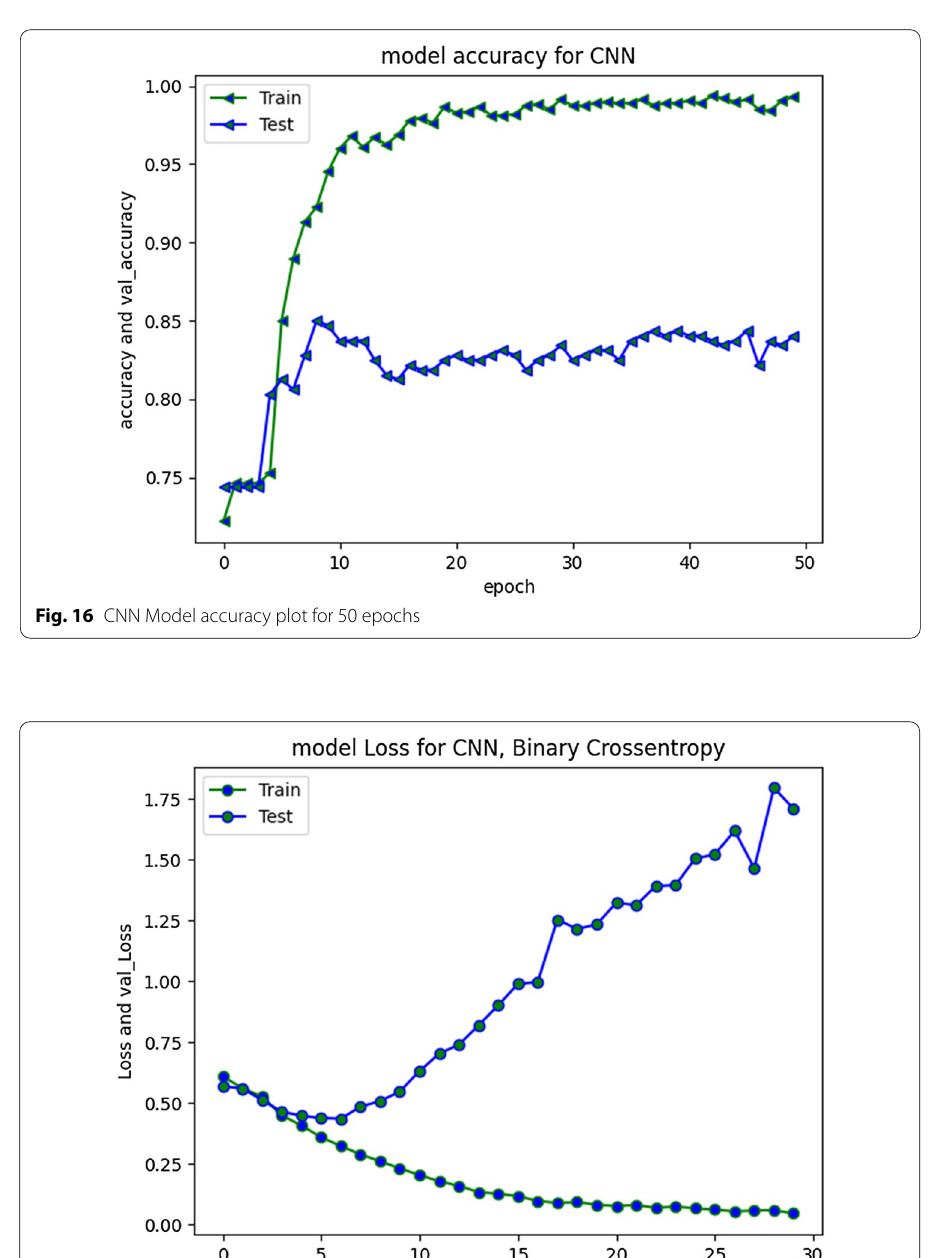
results highlighted that RNN-LSTM and RNN-BiLSTM with concatenation of forward